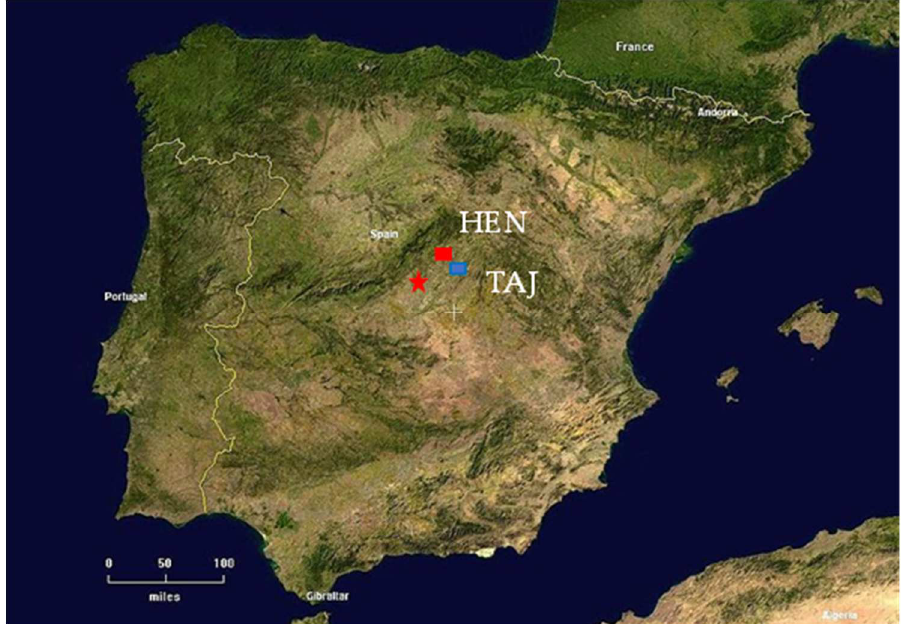
Figure 2. Location of the study sites in Madrid region (central Spain), HEN—Herras de Ayuso (Henares River) and TAJ—Romanones (Tajuna River).